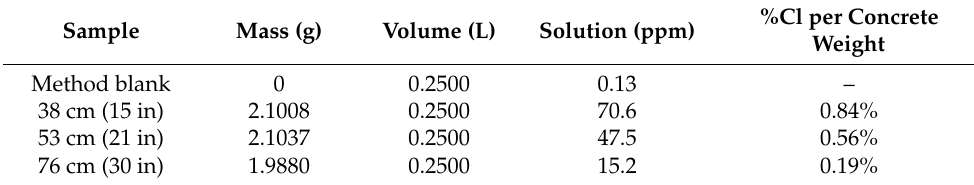
Table 5. Percentage of chloride content per weight of concrete (1st iteration).